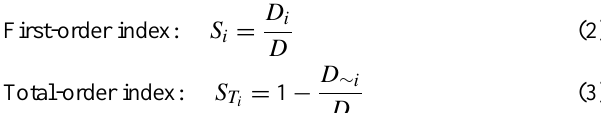
Fig. 1b, resulting in a total basin area of 1248 km 2 .